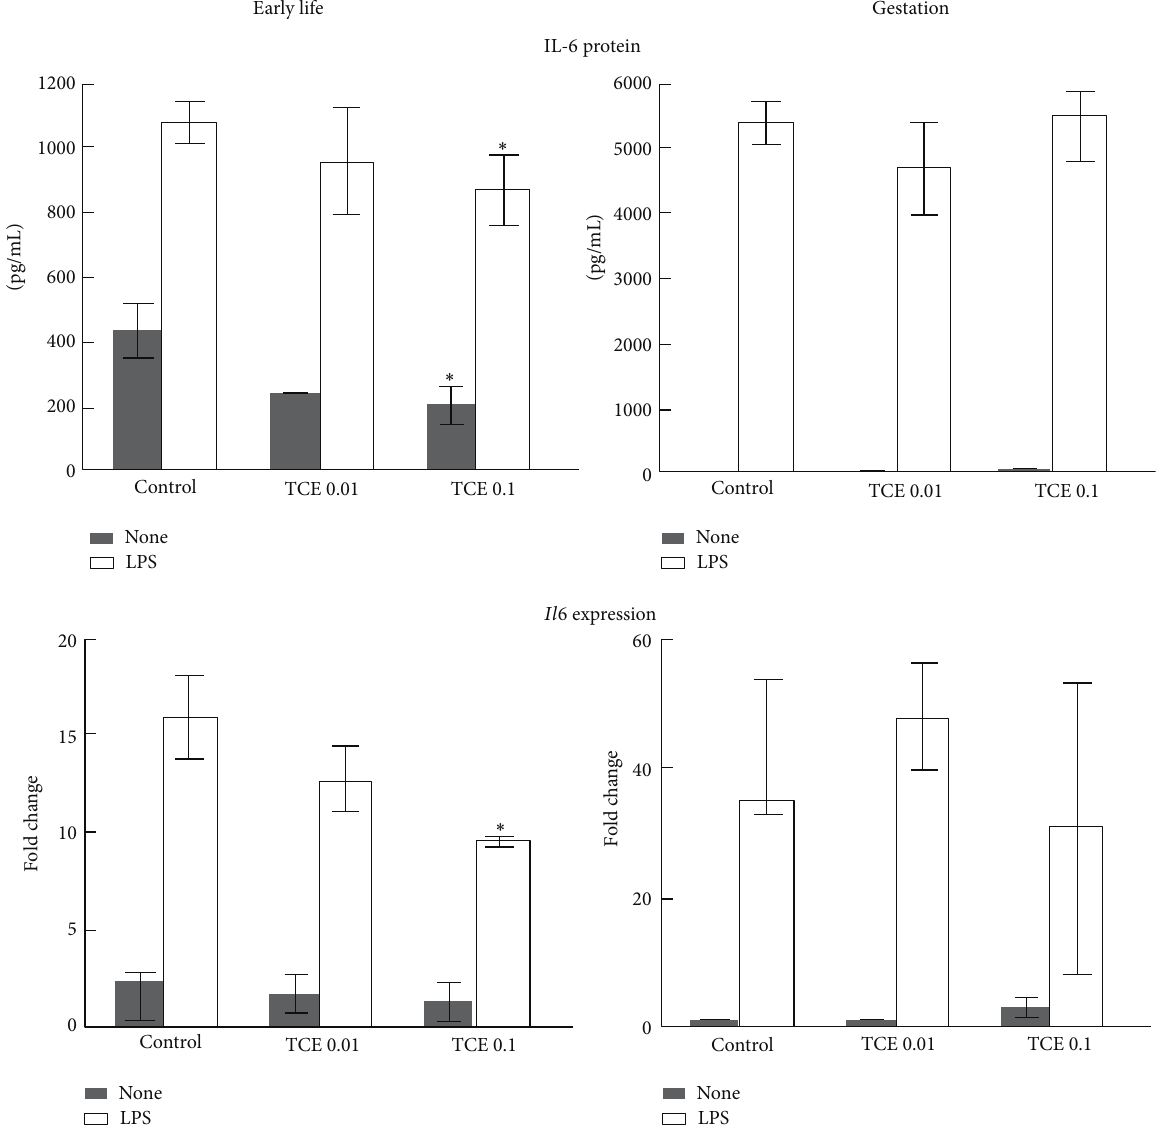
Figure 2: TCE inhibited IL-6 production and Il6 expression in macrophages. Peritoneal macrophages were incubated with LPS and IFN- 𝛾 following isolation from untreated control mice or from mice exposed to TCE (0.01 or 0.1mg/mL) during gestation only or during early life only. Culture supernatants were examined for IL-6 (mean ± SD). Il6 gene expression was examined in the same peritoneal macrophages. The data represents the mean ± SD. ∗ Significantly different ( 𝛼 < 0.05 ) compared to control